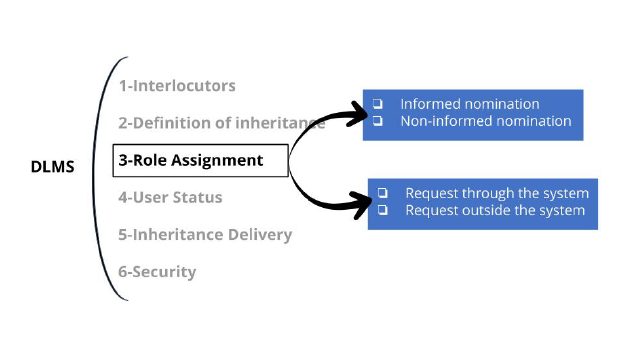
Fig. 5. User Status in DiLeMa Framework.